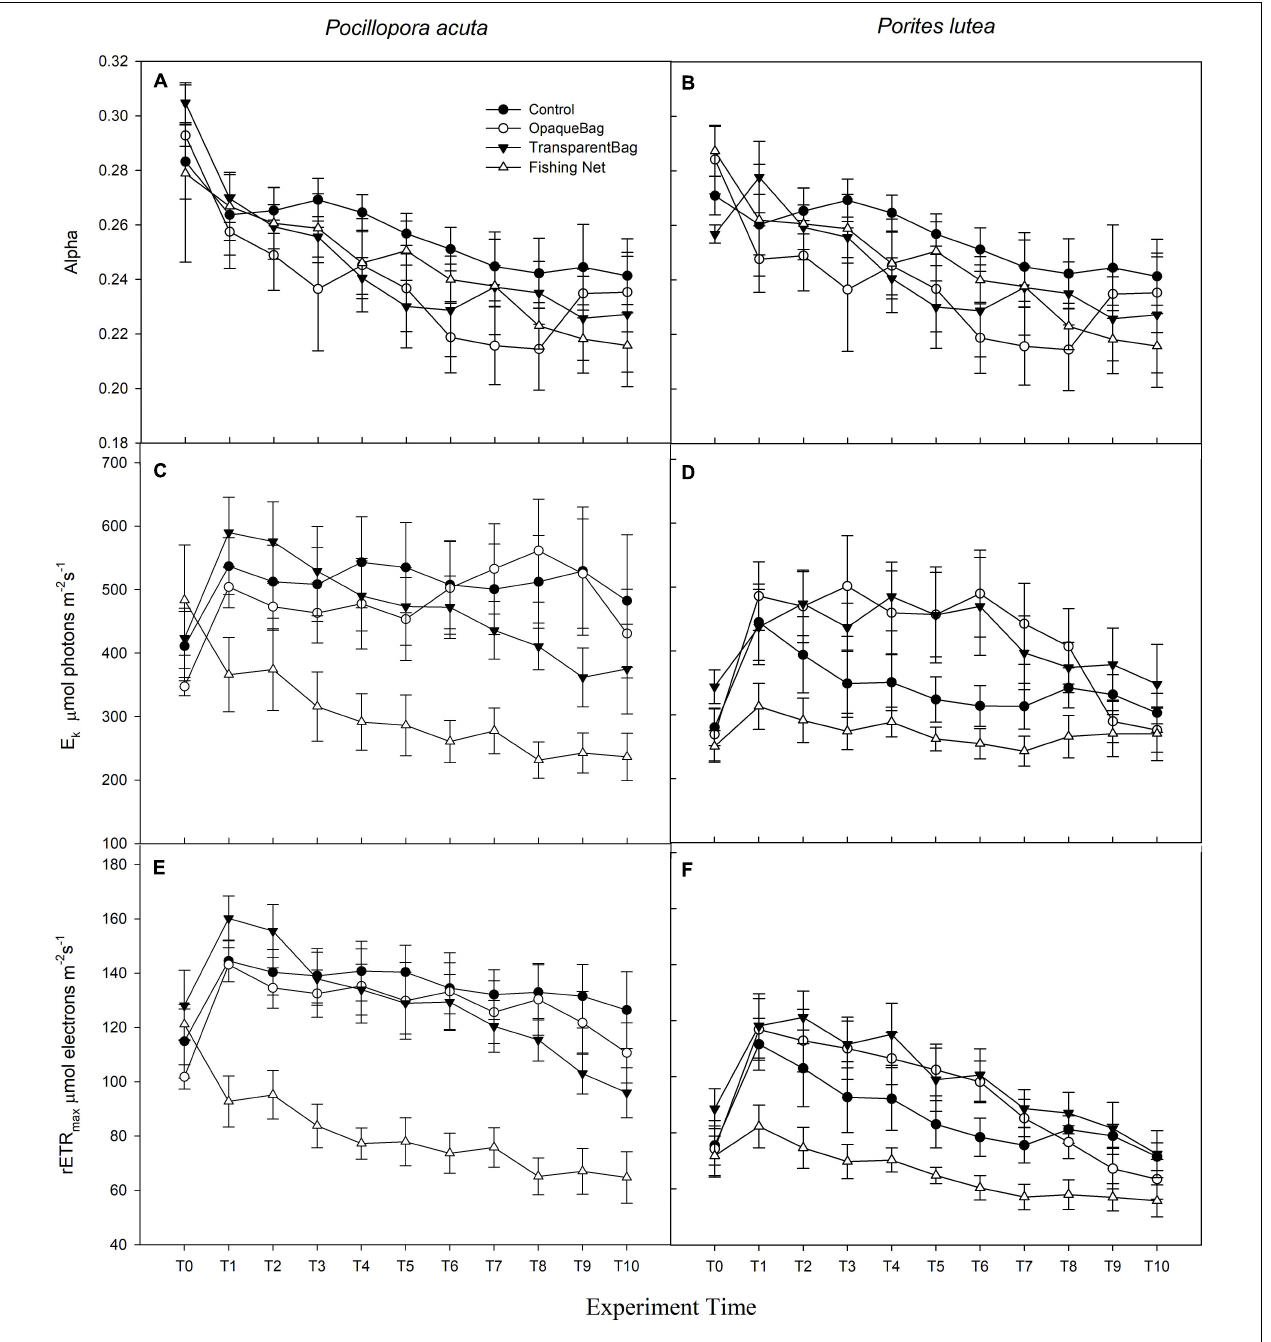
FIGURE 4 | Alpha (A,B) , E k ( C,D ; µ mol photons m − 2 s − 1 ), and rETR max ( E,F ; µ mol electrons m − 2 s − 1 ) of P. acuta (left column charts), and P. lutea (right column charts) from T0 to T10 (Graph treated with moving average, T1 in week 1, T4 in week 2, T7 in week 3, and T10 in week 4). Data are presented as Mean ± SE ( n = 6).